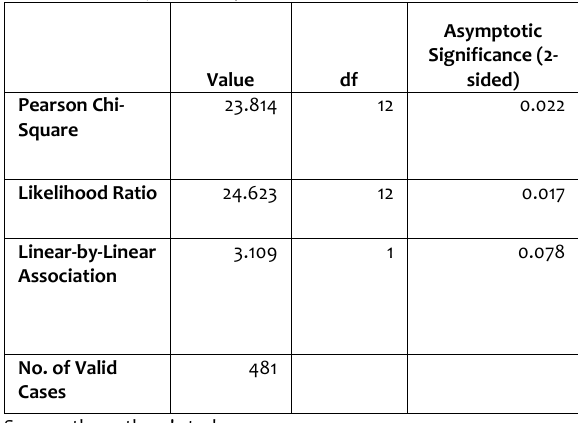
Table 3. Results of the Chi-Square